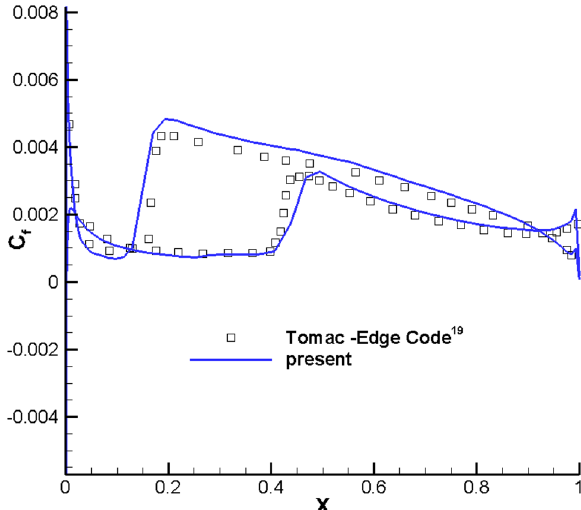
Figure 3. Skin friction coefficient distribution of RAE2822.